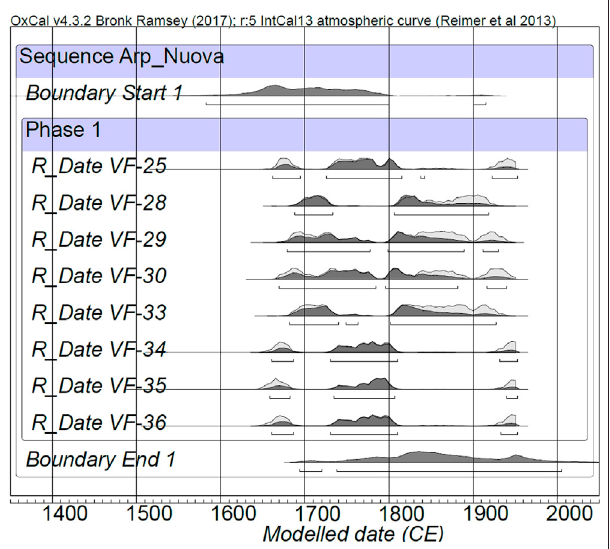
FIGURE 5 | Calendar age intervals as a result of calibration. 14 C ages of wood fragments from Arp Nova pits calibrated using the phase model of OxCal. Dark gray areas show posterior probability distributions resulting from the Bayesian phase model of OxCal. The light gray areas show the standard (unmodelled) probability